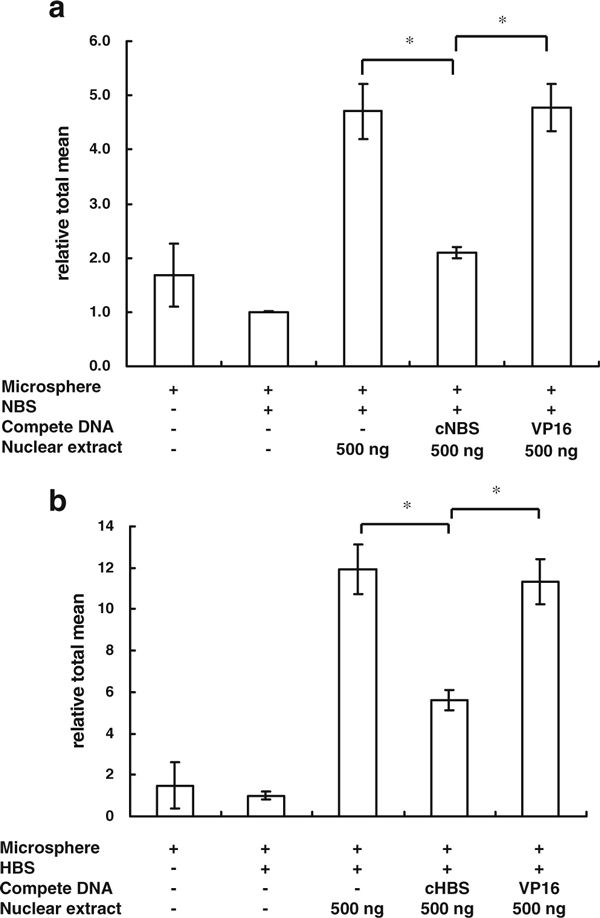
The MIA-TF method was used to detect the activity of transcription factors. a The MIA-TF method was used to detect the changes in NF-κB expression in 500 ng of nuclear extract. b The MIA-TF method detected the changes of HIF-1 expression in 500 ng of nuclear extract. Relative total mean = EventsR1 × MeanR1/EventsR2 × MeanR2. The results are expressed as mean ± SD. *p < 0.05, n = 6. NBS biotin-labeled dsDNA containing five NF-κB binding site, cNBS non-biotin-labeled NBS, HBS biotin-labeled dsDNA containing seven HIF binding sites, cHBS non-biotin-labeled HBS, VP16 non-biotin-labeled dsDNA containing no HBS and NBS.